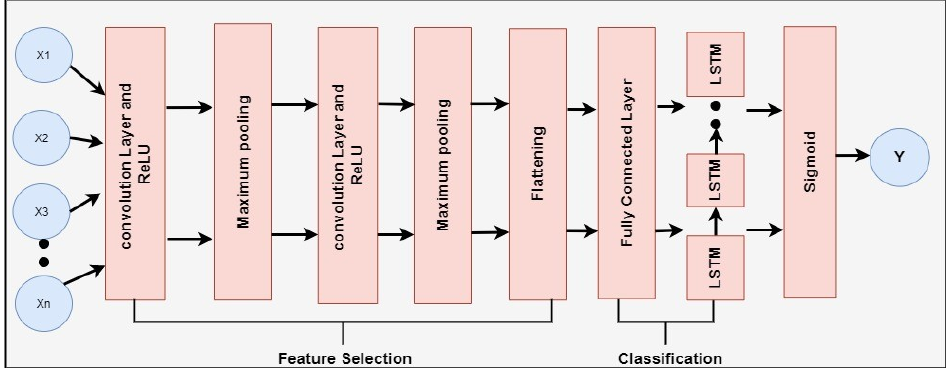
Figure 5. Architectural CNN-LSTM Model for Diabetes